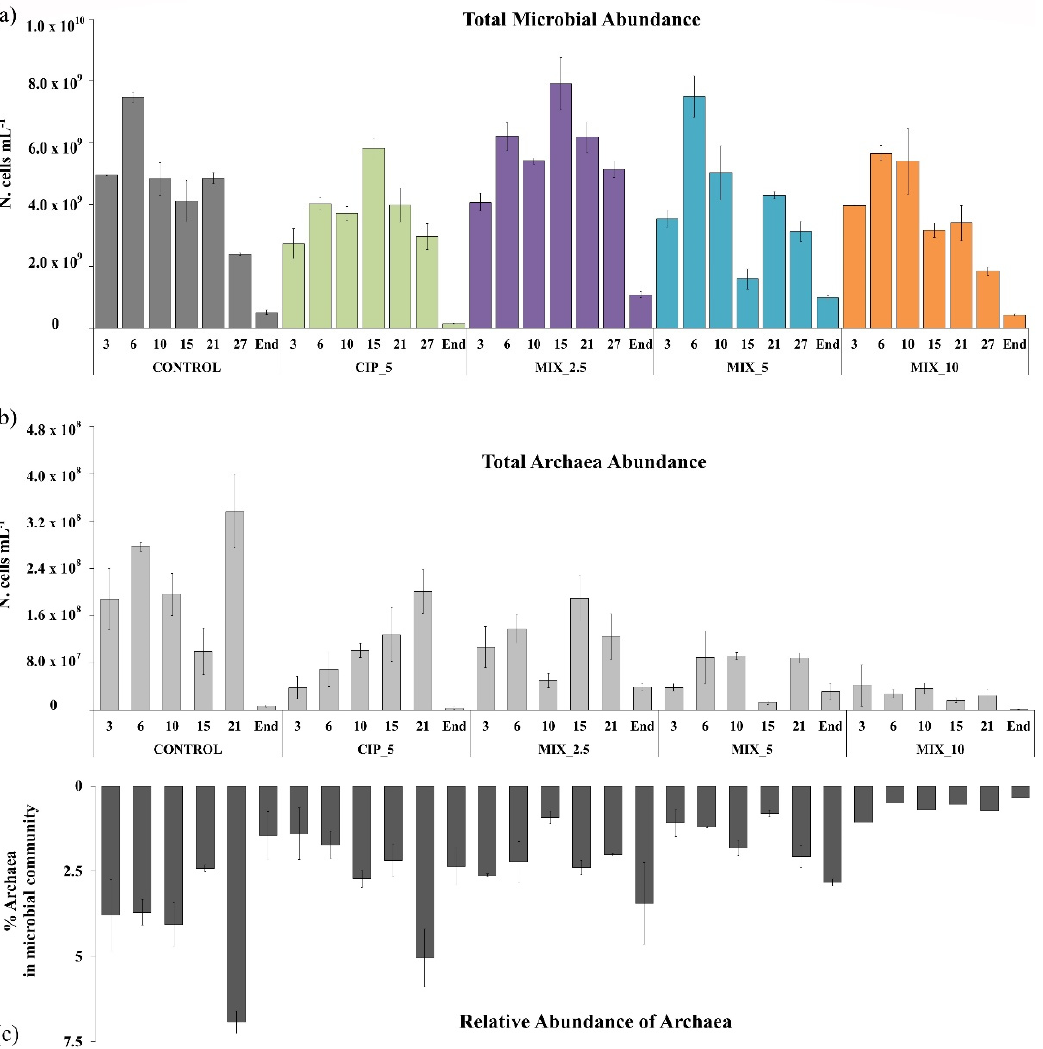
Figure 4. ( a ) Total microbial abundance (N. cells mL − 1 ) detected by direct counts after DAPI staining for all experimental conditions over the experimental time (days 3, 6, 10, 15, 21, 27, end). ( b ) Microbial abundance (N. cells mL − 1 ) of Archaea estimated combining DAPI and FISH results. ( c ) Relative abundance (%) of Archaea .